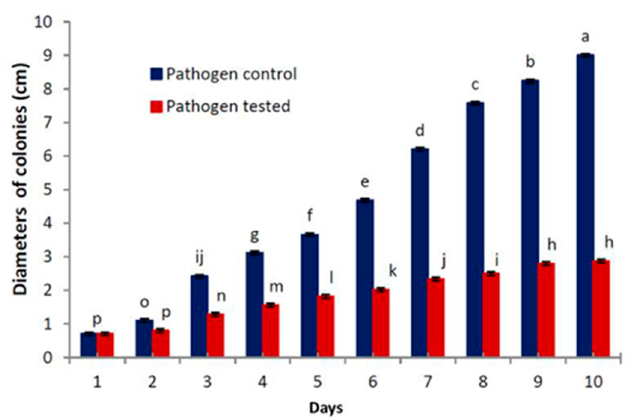
Figure 3. Mycelial growth of pathogen A. brassicicola confronted against strain C. virescens for 10 days. Mean and standard deviation is expressed in the error bar ( n = 5). Different letters indicate a significant difference (Tukey test, p ≤ 0.05).